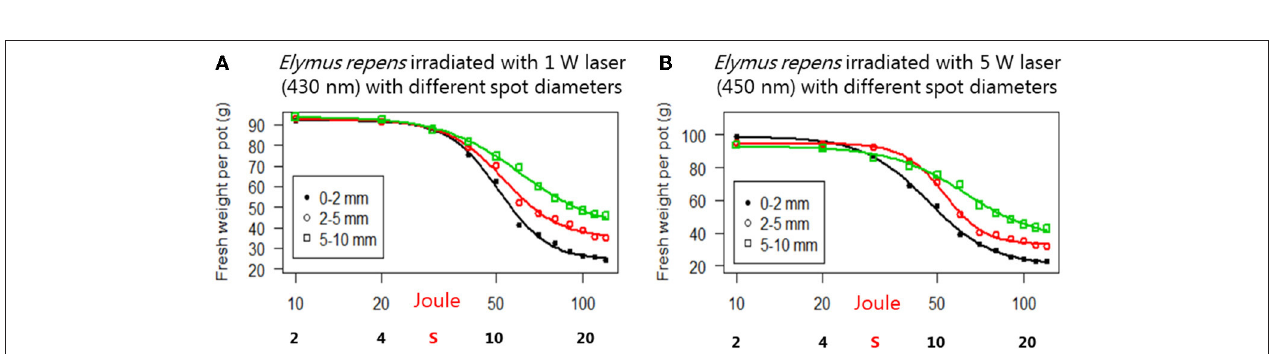
FIGURE 2 | Dose-response curves. (A) Elymus repens (L.) Desv. ex Nevski. plants were exposed to a 1W laser (435nm) beam and (B) to a 5W laser (450nm) beam. Three diameters ( + / − 0.05mm) of the internal spot of the laser beams were used. The plants were harvest 40 days after laser exposure (modified from Rakhmatulin and Andreasen, 2020